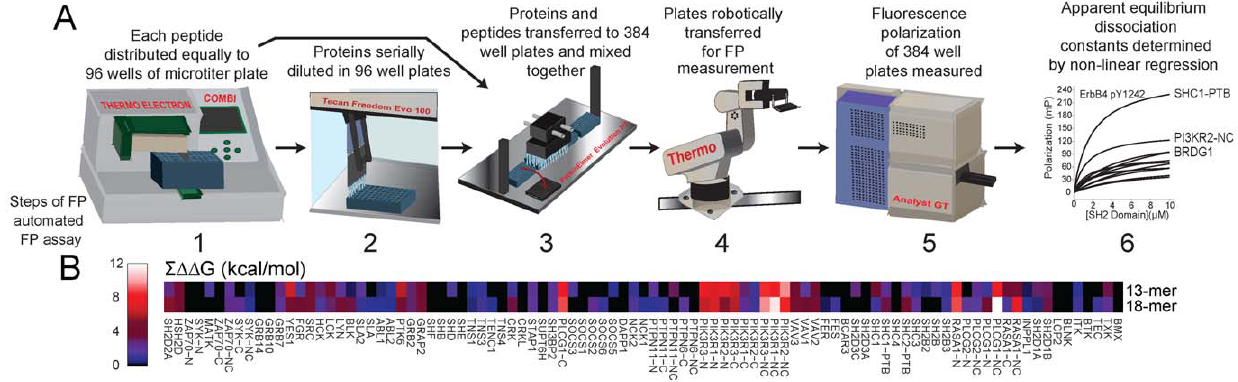
Figure 1. Automated high-throughput fluorescence polarization (FP) procedural schematic. ( A ) ( 1 ) Following synthesis and mass- directed purification, 10 m L of phospho-peptide (10 nM) labeled on the N-terminus with rhodamine is distributed equally to each well of a 96-well plate. ( 2 ) After expression and purification, 8 SH2 domains at an original concentration of 20 m M are serially diluted 11 times in two-fold increments into 96-well plates. ( 3 ) Proteins from 96-well plates are added in four pipetting steps to a single 384-well plate. To the same plate, 12 different concentrations of eight different SH2 domains are added to each quadrant of the 384-well plate. In total, 32 unique SH2 domains at 12 different concentrations are mixed with a single peptide. ( 4 ) Following an incubation period of 20 min, 384-well plates of SH2 domains and peptides are delivered to the Analyst GT ( 5 ) for measurement of FP. Data from these measurements are used for determining apparent dissociation constants ( 6 ). ( B ) Comparison of binding data using 13-mer- and 18-mer peptides. Heat maps depict summations of relative binding free energies ( DD G, kcal/mol) as a function of apparent K D s of SH2 and PTB domains interacting with indicated peptides (see equation 1 in text). DD G summations are color coded by binding